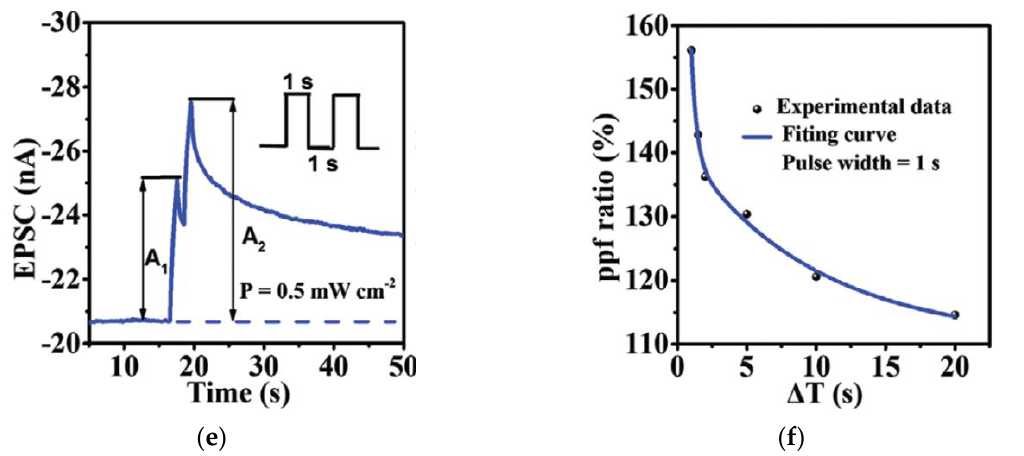
Figure 7. PPF characteristics and PPF index of synaptic transistors based on natural organic materials: ( a , b ) gelatin [15], ( c , d ) chicken albumen [43], ( e , f ) chlorophyll-a [57].